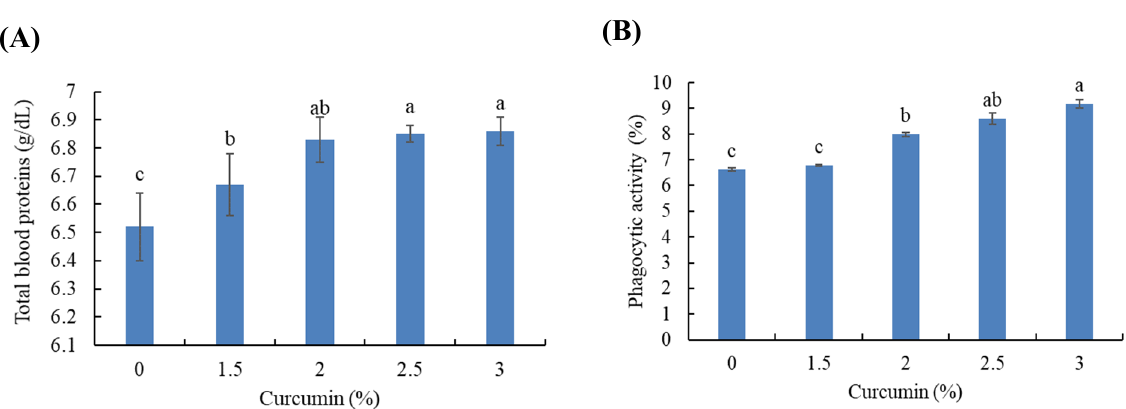
Figure 2. Blood total protein ( A ) and phagocytic activity ( B ) in Gilthead seabream fed varying levels of dietary curcumin for 150 days. Bars with different letters are significantly different ( p < 0.05) ( n = 3).